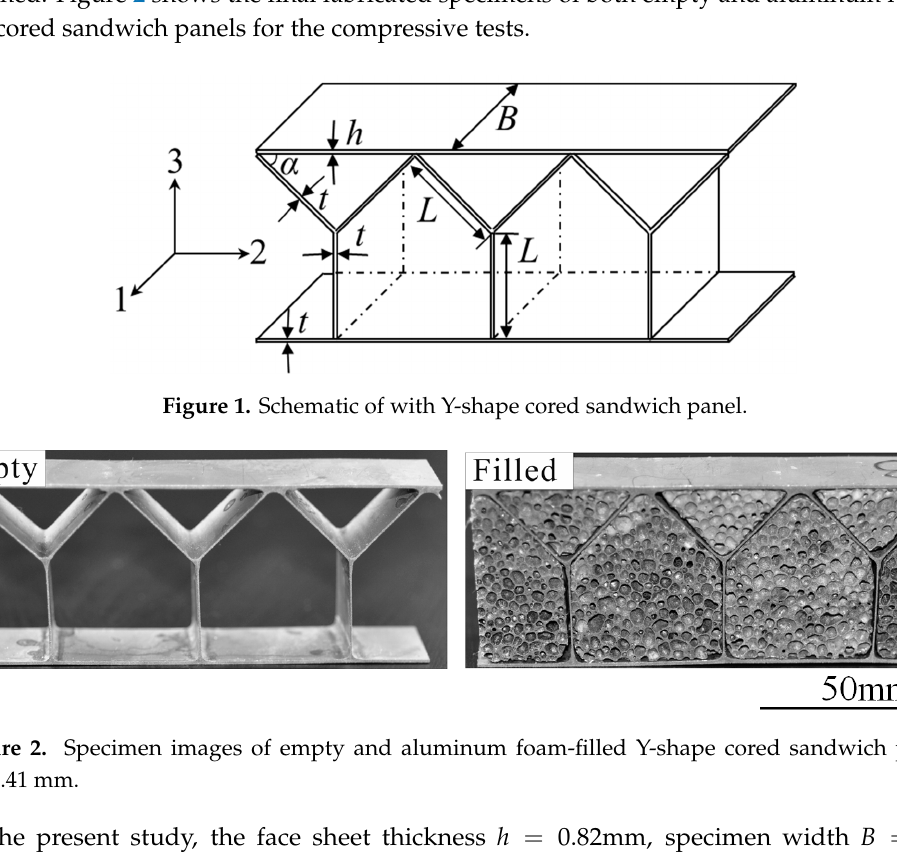
Figure 1. Schematic of with Y-shape cored sandwich panel.